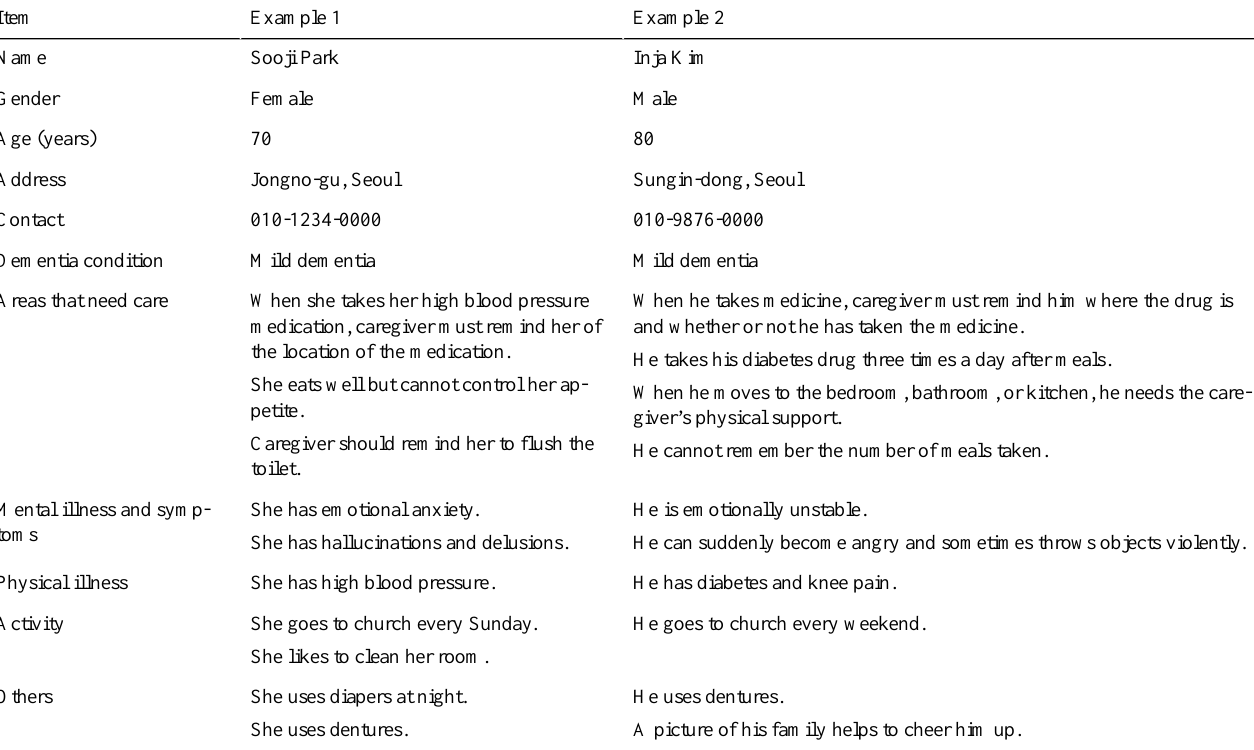
Table 1. Assessment information on people with dementia obtained from the care center in Korea. Personal information such as name, gender, and address are